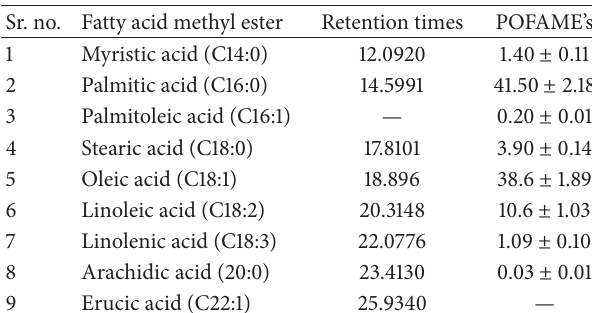
Table 5: Major fatty acid methyl esters of palm oil